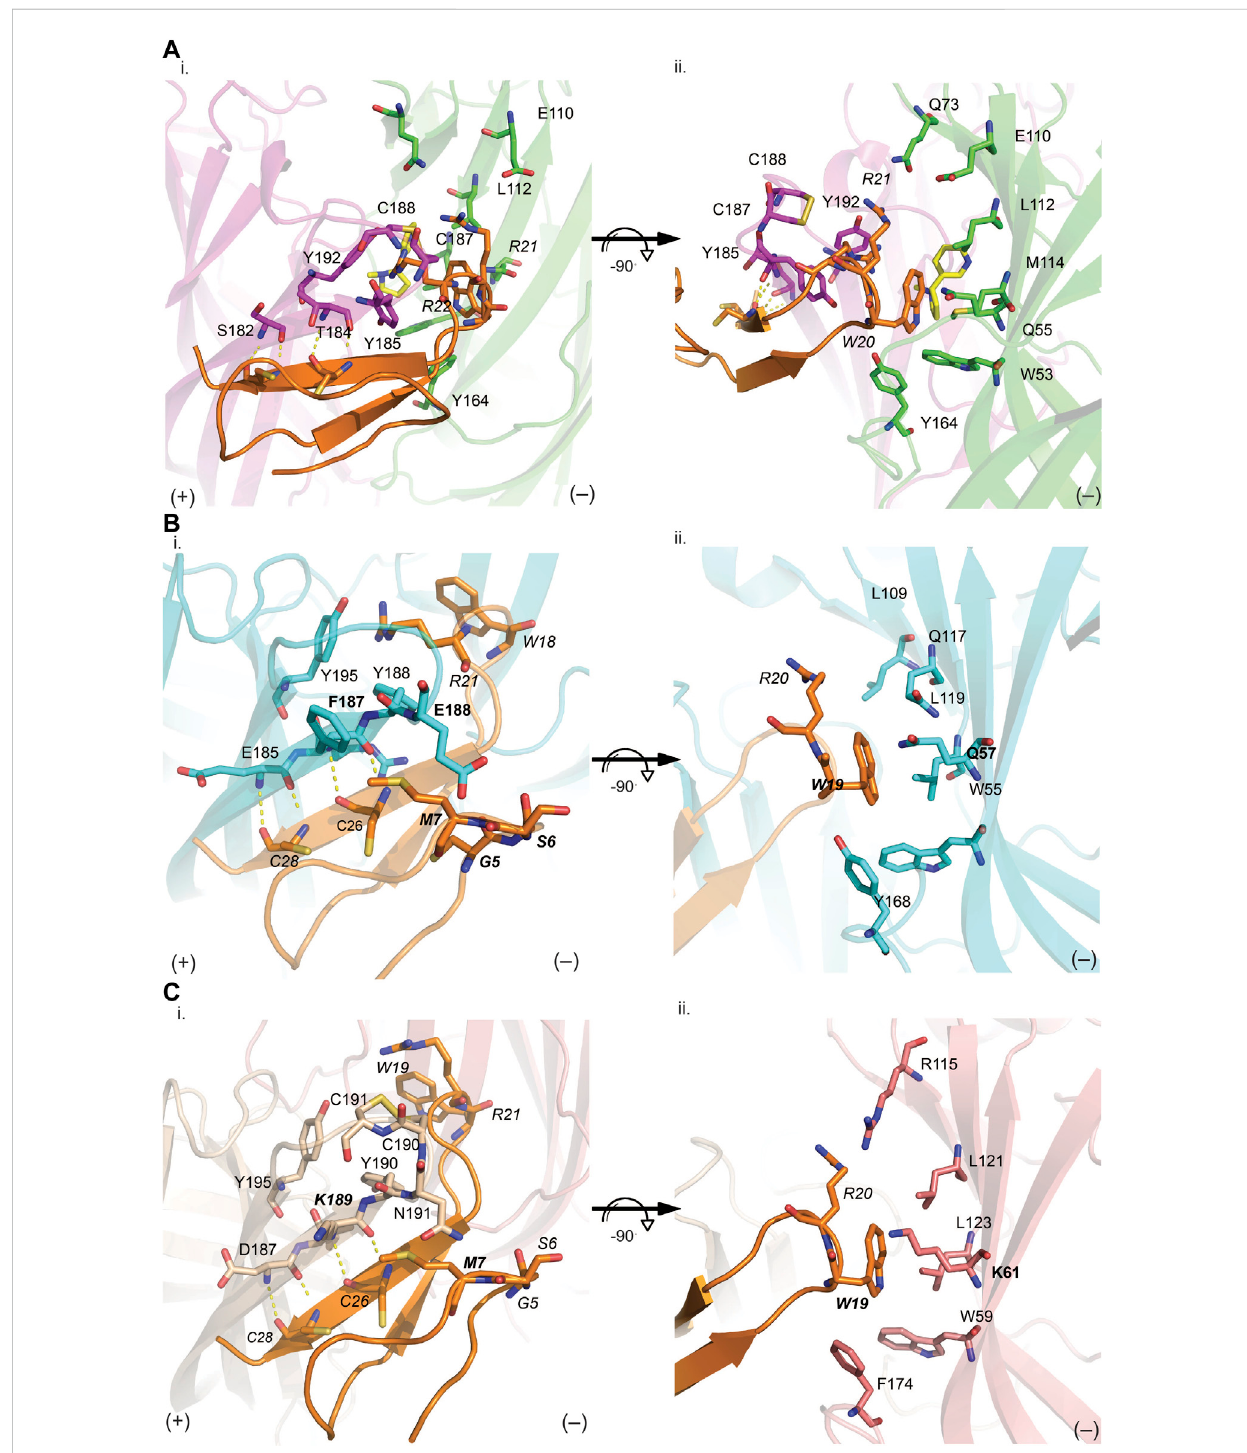
FIGURE 5 VxXXB-C(21 – 50)interactionsattheprincipal(i)andcomplementary(ii)bindingsiteof Ls -AChBP (A) ,human α 7nAChRs (B) andhuman α 3 β 4nAChRs (C) . (A) Thereceptorligandinteractionsareuniquelycharacterizedbyhydrogenbondsbetweenthe β -sheetofCTD(21 – 50)withtheprincipalbindingsite (i) and polar bonds on the complementary binding site (ii). The homology models of human α 7 receptor (B) and human α 3 β 4 nAChRs (C) were generated basedontheVxXXB-C(21 – 50)/ Ls -AChBPco-crystalstructure. (B) Ontheprincipalside(i), α 7_F187and α 7_E189withitslongsidechainscanextend towards VxXXB-C (21 – 50)_C4, G4, S6, and M7, and exhibit favorable interactions. On the complementary side, similarly, α 7_Q57 could interact with VxXXB-C (21 – 50)_W19. (C) Meanwhile, at α 3 β 4 nAChRs complementary face (ii), the corresponding surface is strongly hydrophobic except for the positively charged K61, which may introduce a cation- π interaction with VxXXB-C (21 – 50)_W19. These interactions likely in fl uence the selectivity